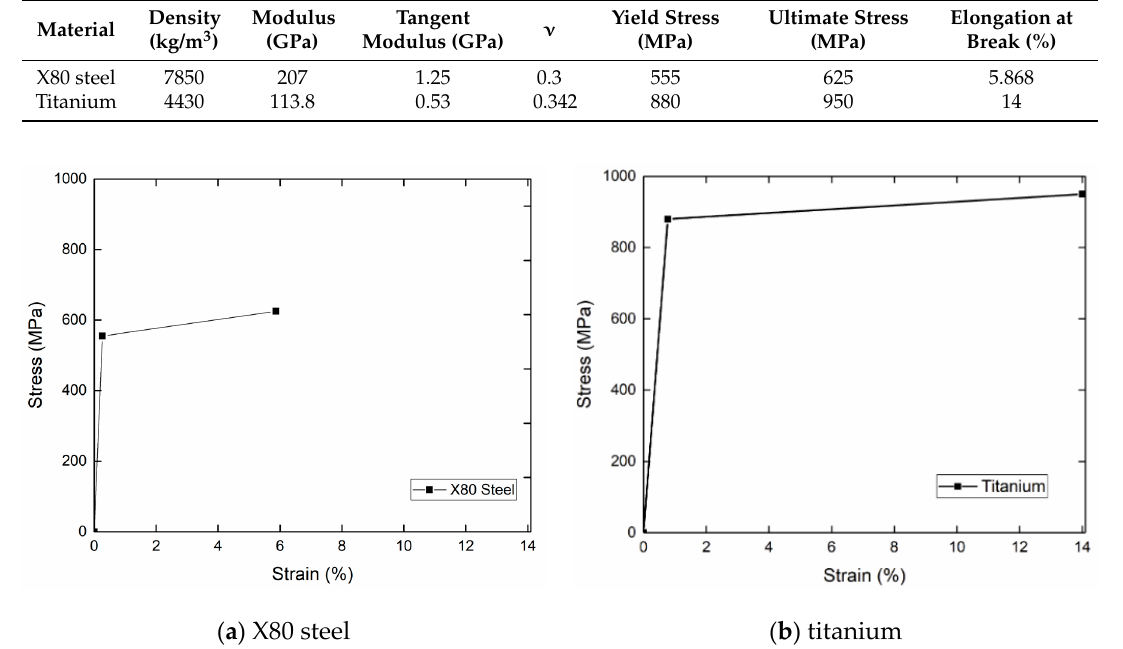
Figure 1. Bilinear kinematic hardening model of ( a ) X80 steel and ( b ) titanium. Table 3. Properties of unidirectional lamina of AS4 ‐ Epoxy for composite risers. Density Material (kg/m 3 )